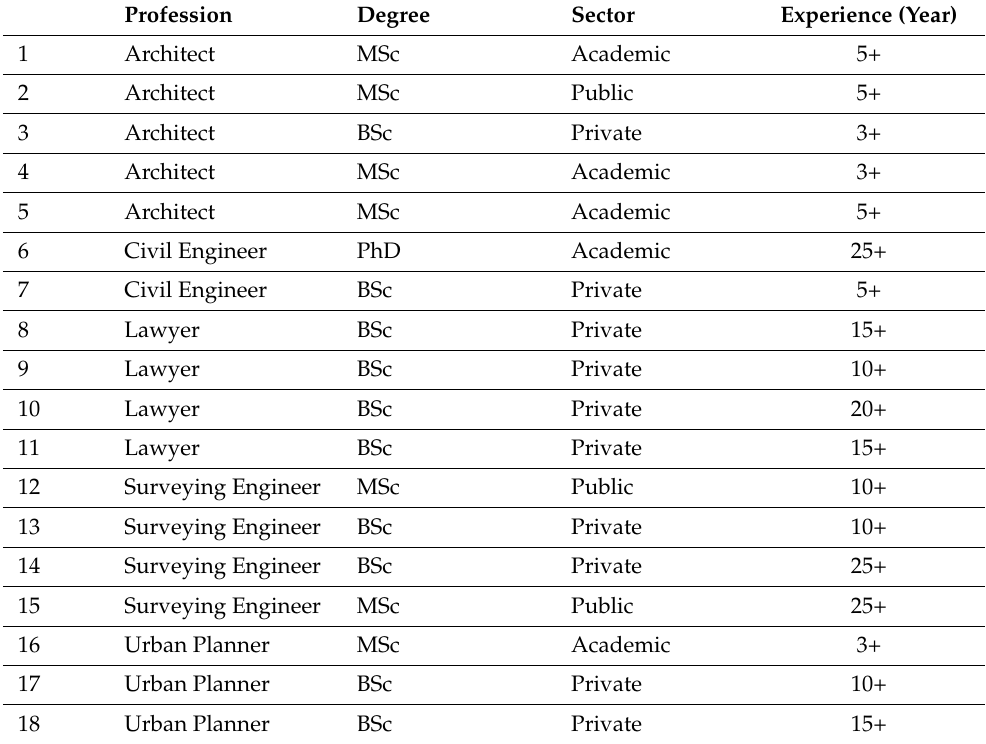
Table 4. Careers of the